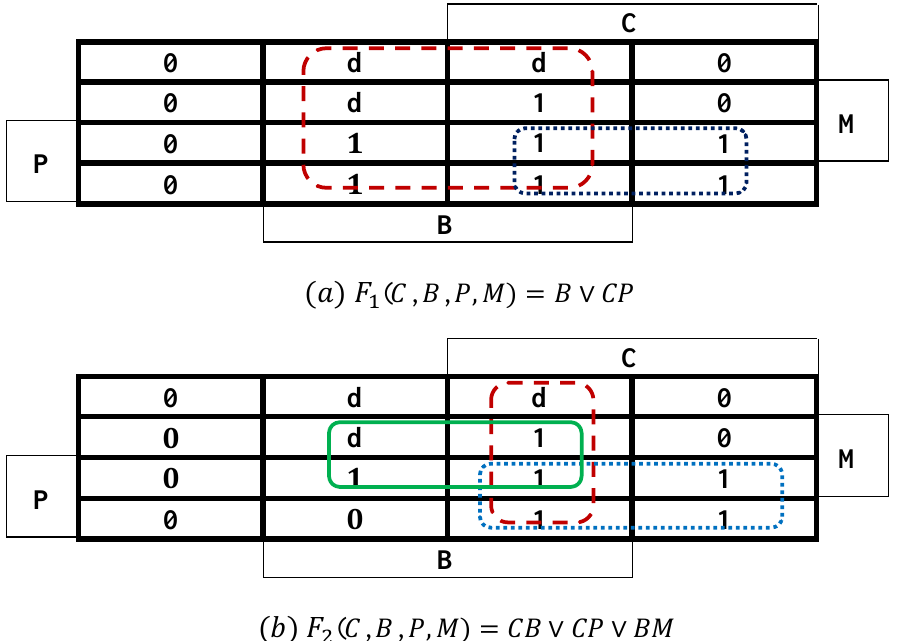
Fig. 11. Two possible solutions depending on two arbitrary assignments for the unresolved